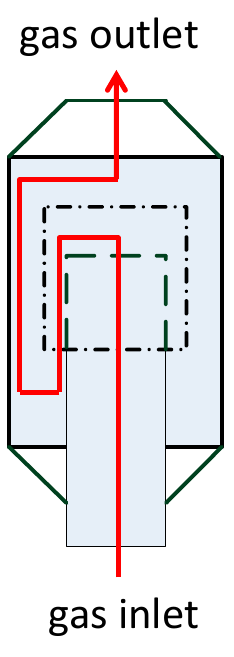
Figure 2. A fire closure as a part of the molecular closure.